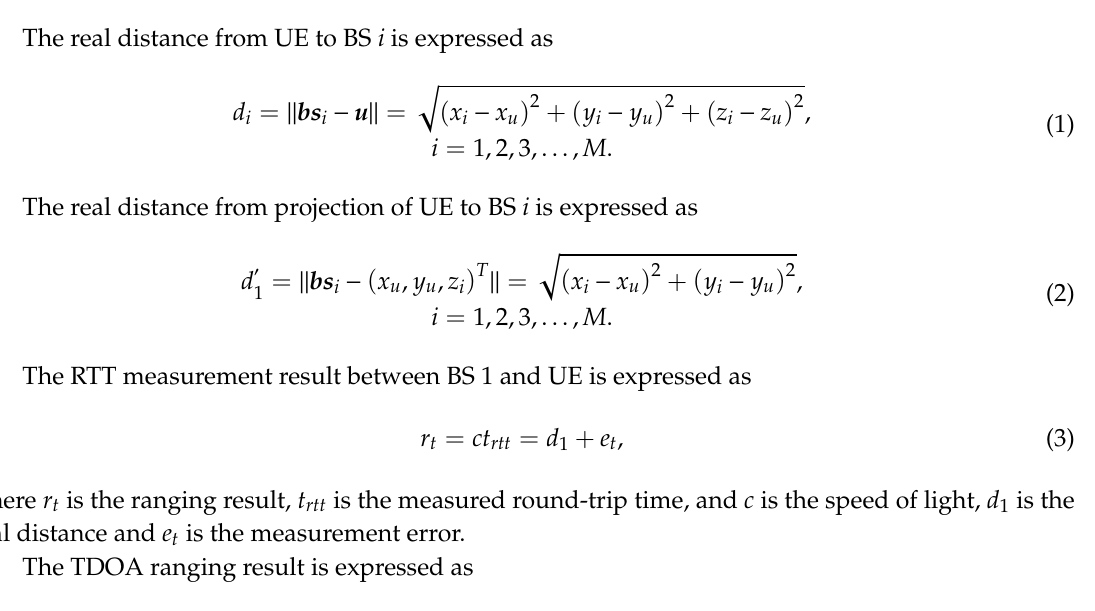
Figure 2. The three-dimension Cartesian coordinate for US positioning.